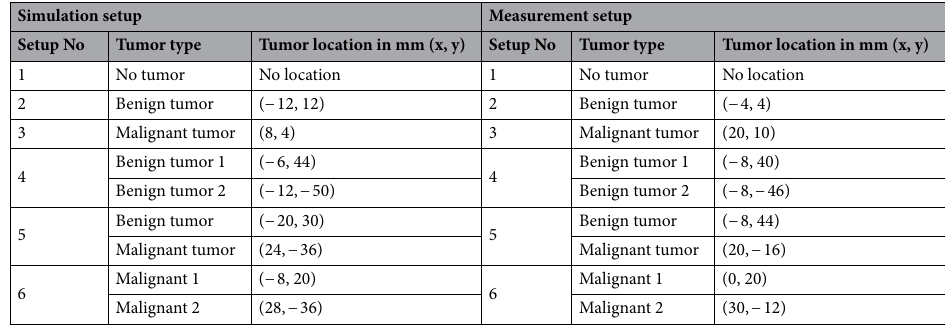
Table 8. Summarized comparison results of tumor location as a cartesian coordinate in reconstructed